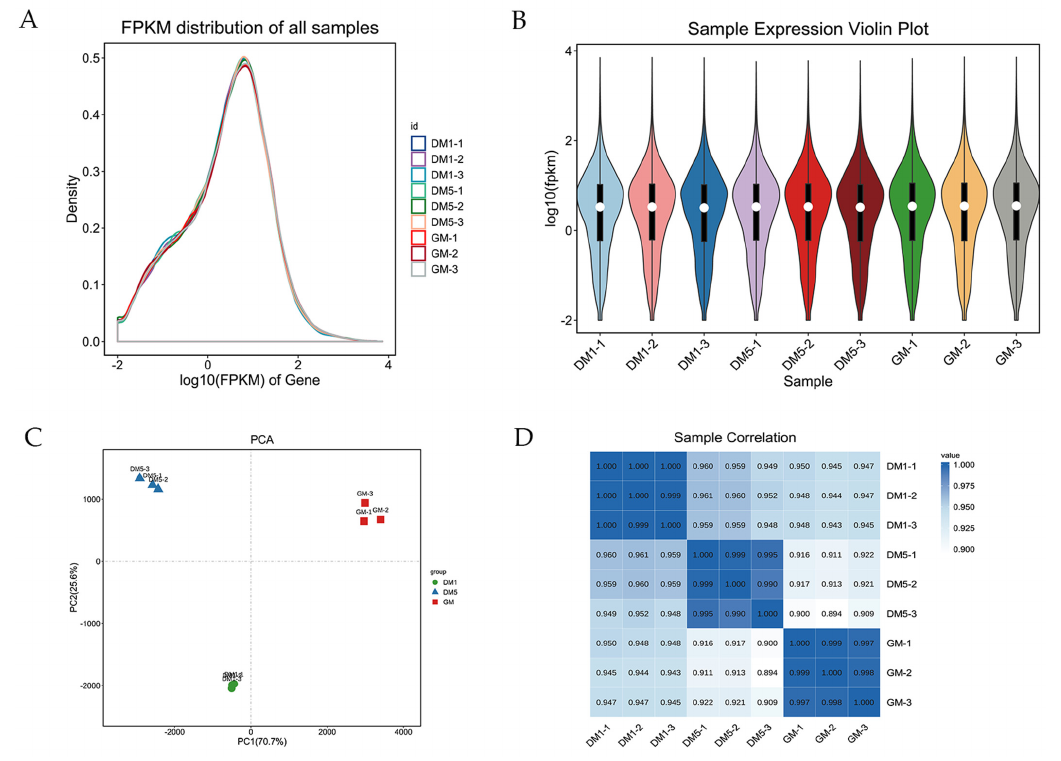
Figure 2. Expression analysis of the mRNA. ( A ) The density distribution of mRNAs was according to log10 (FPKM); ( B ) the nine sample expressions of GM − 1, GM − 2, GM − 3, DM1 − 1, DM1 − 2, DM1 − 3, DM5 − 1, DM5 − 2, of DM5 − 3 in a violin plot, which was replaced by log10(FPKM); ( C ) the PCA analysis of 9 samples; ( D ) the sample relationship cluster analysis.